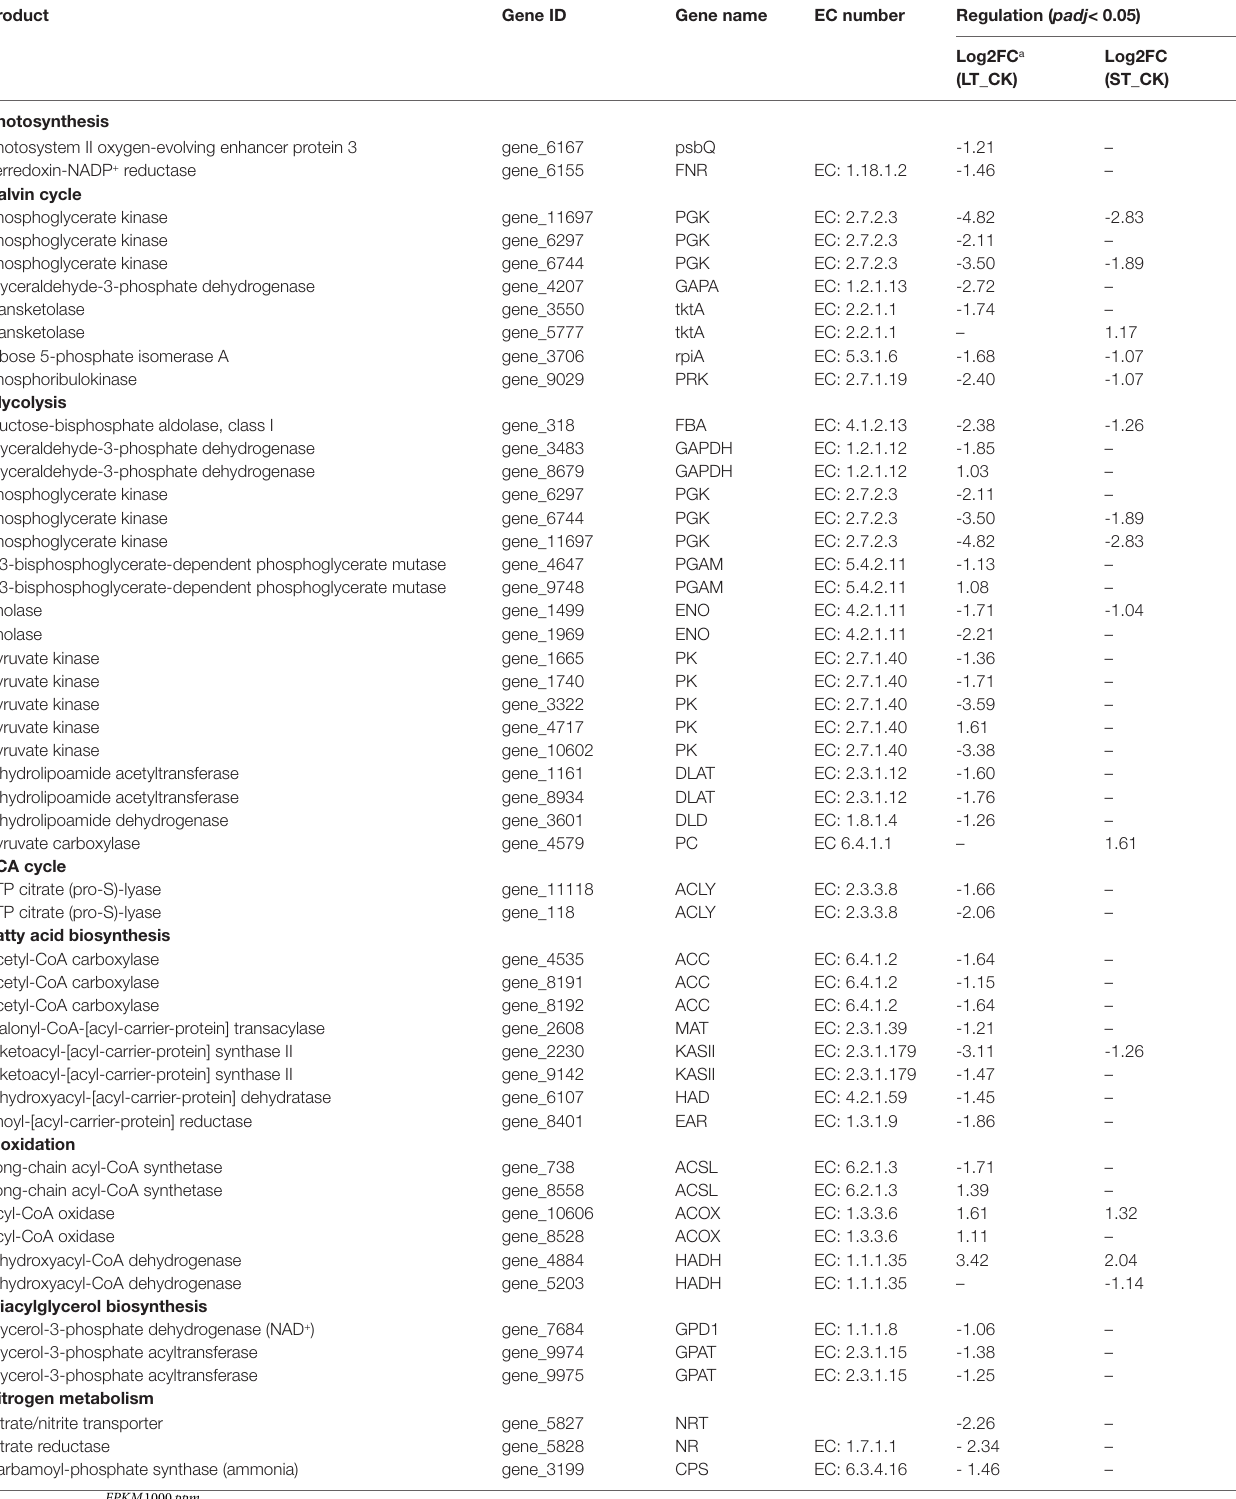
TABLE 7 | Differentially expressed genes related to C and N